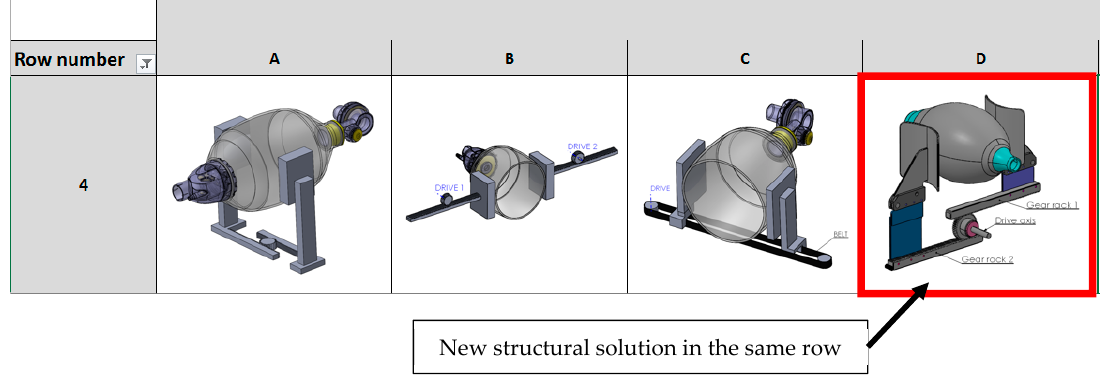
Figure 11. The solution of Figure 9 added to the same row of the chart that inspired the designer (see [71] for the full-size view).